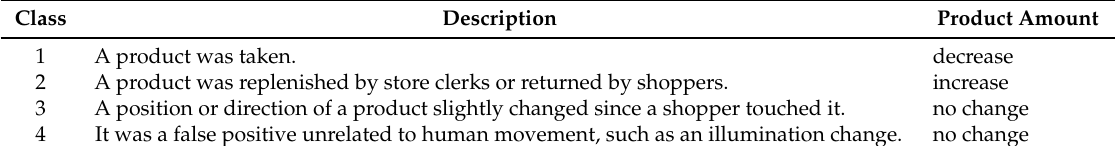
Table 1. Output of our network in product change classification.